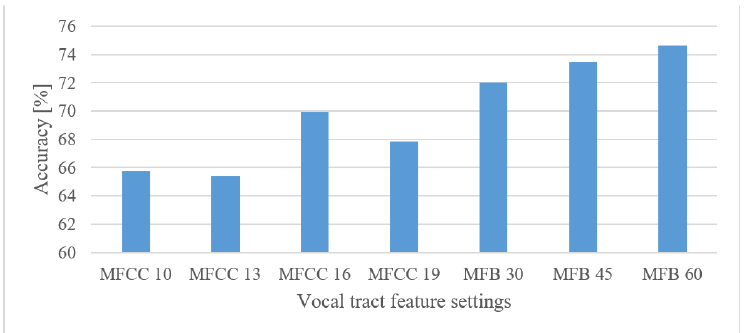
Figure 12. Averaged accuracies for 30, 45, and 60 MFBs, and 10, 13, 16, and 19 MFCC coefficients for an 8 kHz maximal frequency.